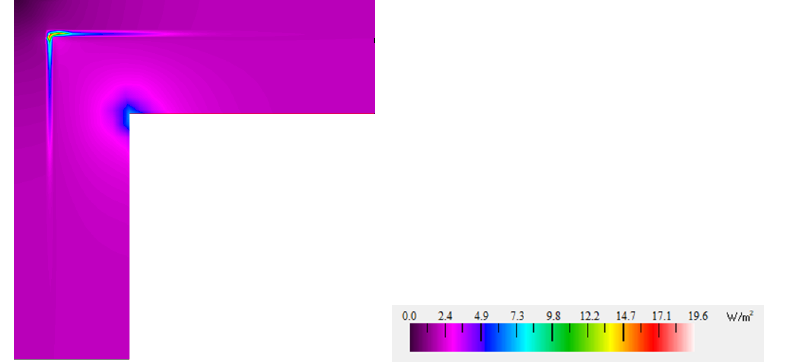
Figure 8. The heat flow rate through the wall corner insulated with aluminum foil-faced PIR, with removed aluminum foil and without PU glue in the joint.